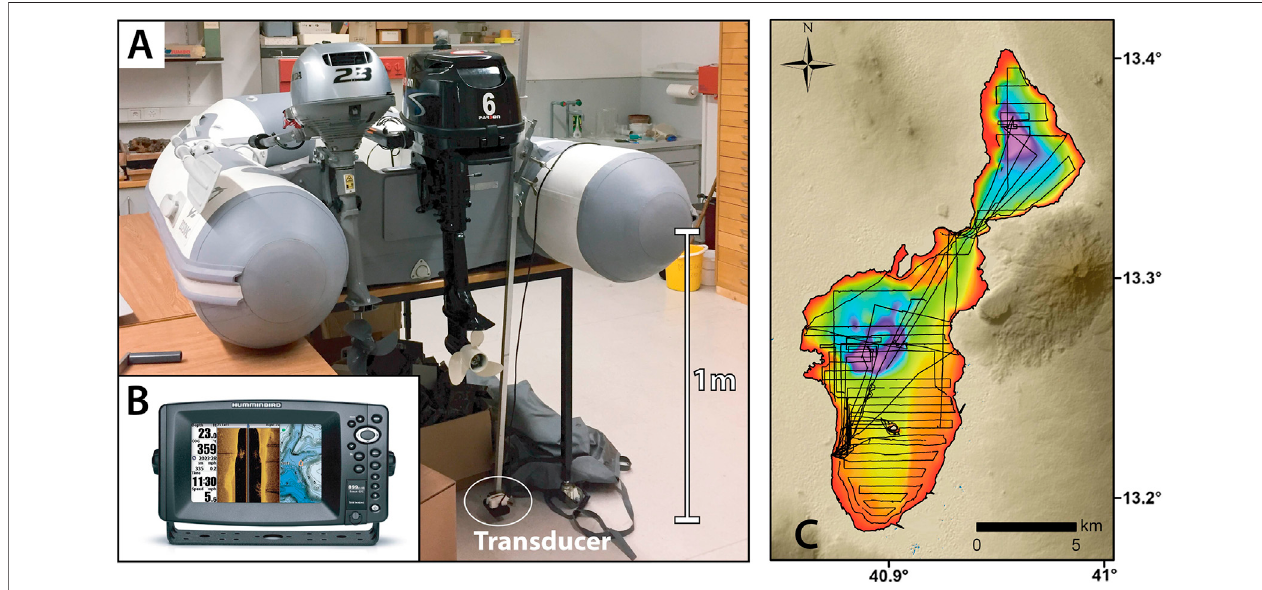
FIGURE 2 | Material used during the bathymetric mapping. (A) . Rigid In fl atable Boat (Zodiac Cadet 270 Aero) with two engines (Parson 6HP water-cooled and Honda 2.3 HP air-cooled engines). The sonar transducer is attached to a perch plunged at 1 m below lake level. (B) . Echosounder Humminbird 899ci hd si . (C) . Map of the multibeam survey tracklines acquired during the two surveys in January 2016 and January 2017.